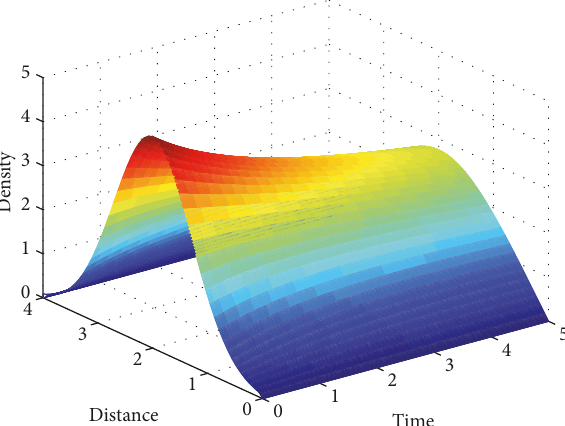
Figure 3: Density evolution at 𝑥 = 2 and 𝑥 = 4 with the finite-time controller.